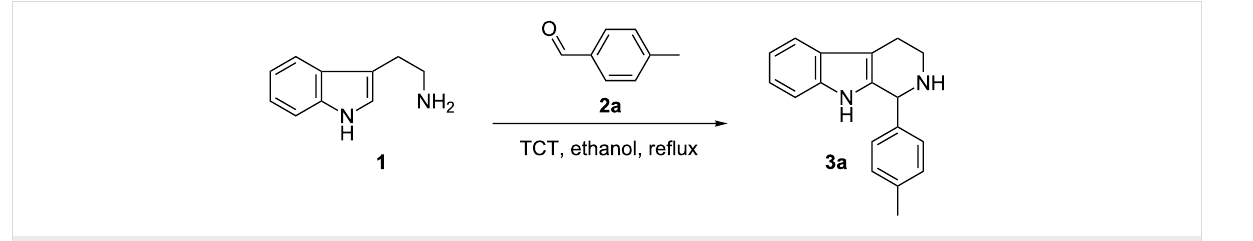
Scheme 1: The Pictet–Spengler reaction of tryptamine with 4-tolualdehyde.